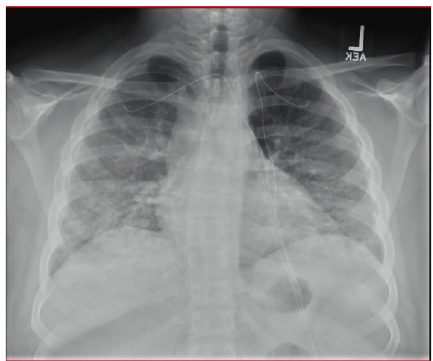
Figure 1: Chest X-ray showing interstitial opacities throughout the perihilar and basal lung regions.